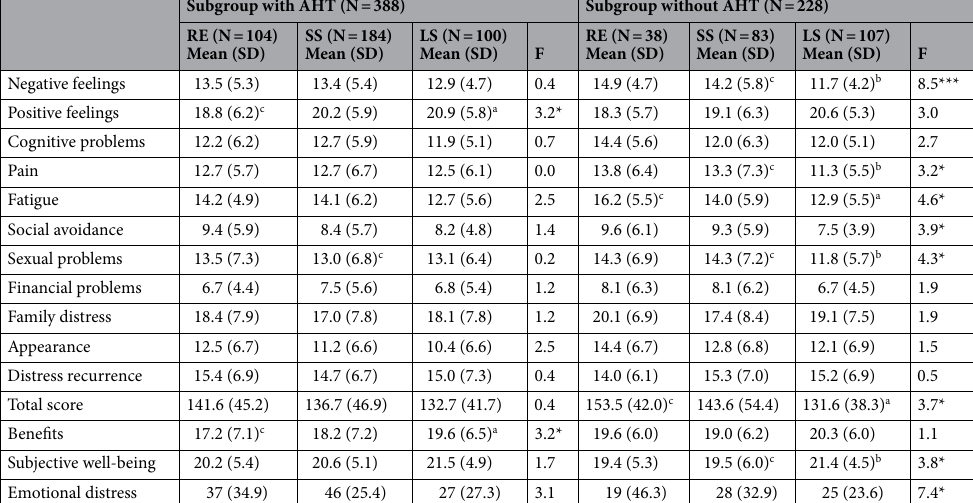
Table 3. ANOVA, post hoc tests and Chi2 for subgroups with and without hormone therapy by survival phase. AHT, adjuvant hormone therapy; RE, re-entry subgroup; SS, short survival subgroup; LS, long survivor subgroup. * = p ≤ 0.05, ** = p ≤ 0.01, *** = p ≤ 0.001. a Significant differences with re-entry phase, b significant differences with short survival phase, c significant differences with long survival phase. The family distress subscale has been weighted in order to equalize the rank with the rest of the subscales.